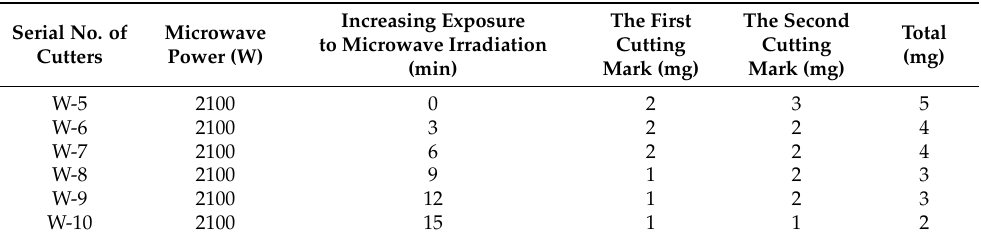
Table 1. Changes in the mass loss of the reduced-scale TBM cutter with increasing exposure to microwave irradiation.